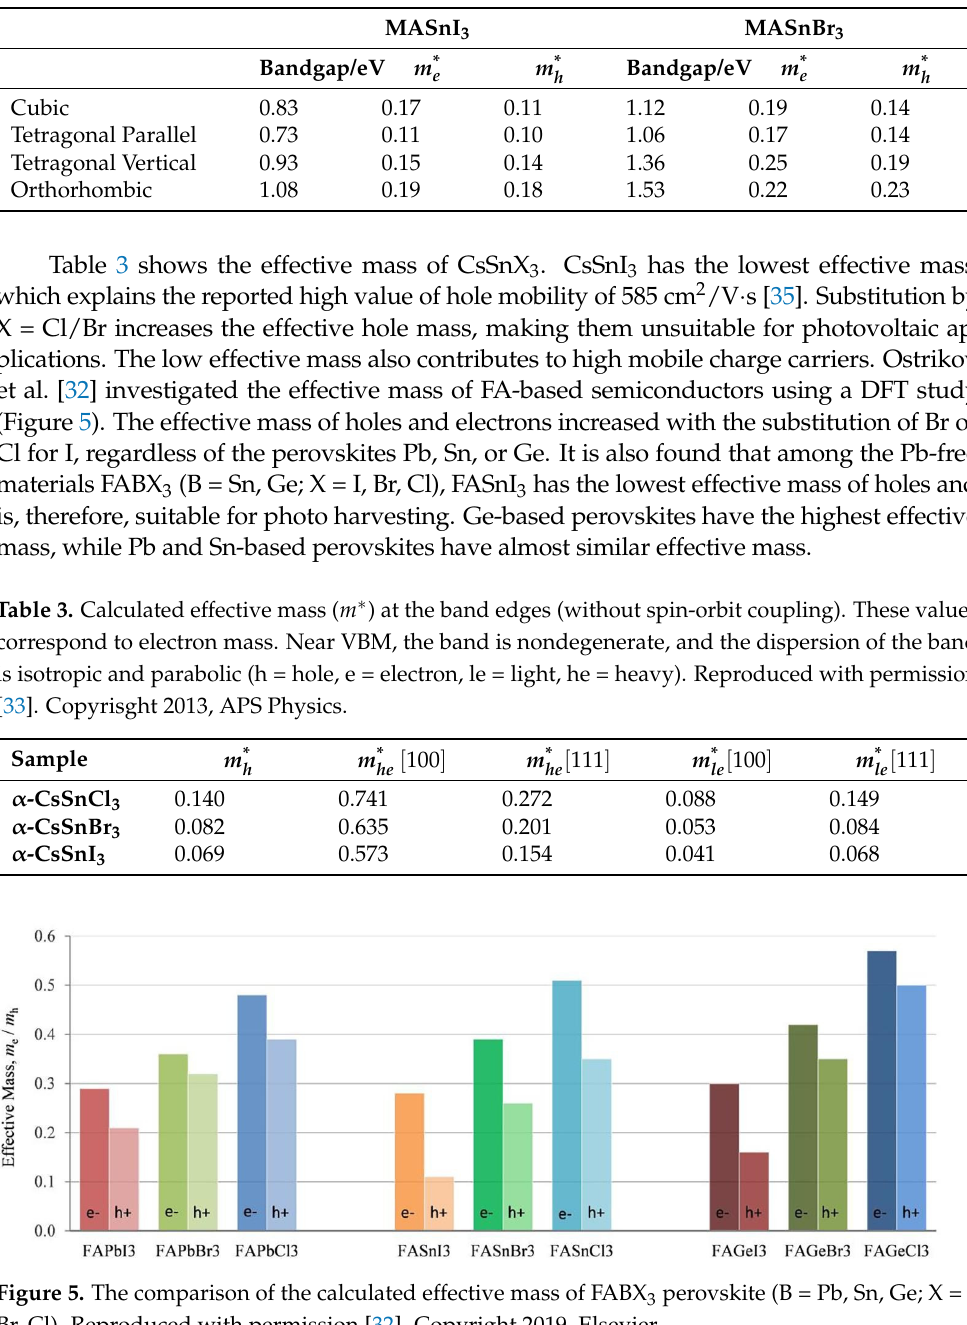
Table 2. Calculated bandgap energy and effective electron and hole mass ( 𝑚 (cid:3032)∗ and 𝑚 (cid:3035)∗ ) of MASnI 3 and MASnBr 3 . Reproduced with permission [34]. Copyright 2016, Springer Nature.